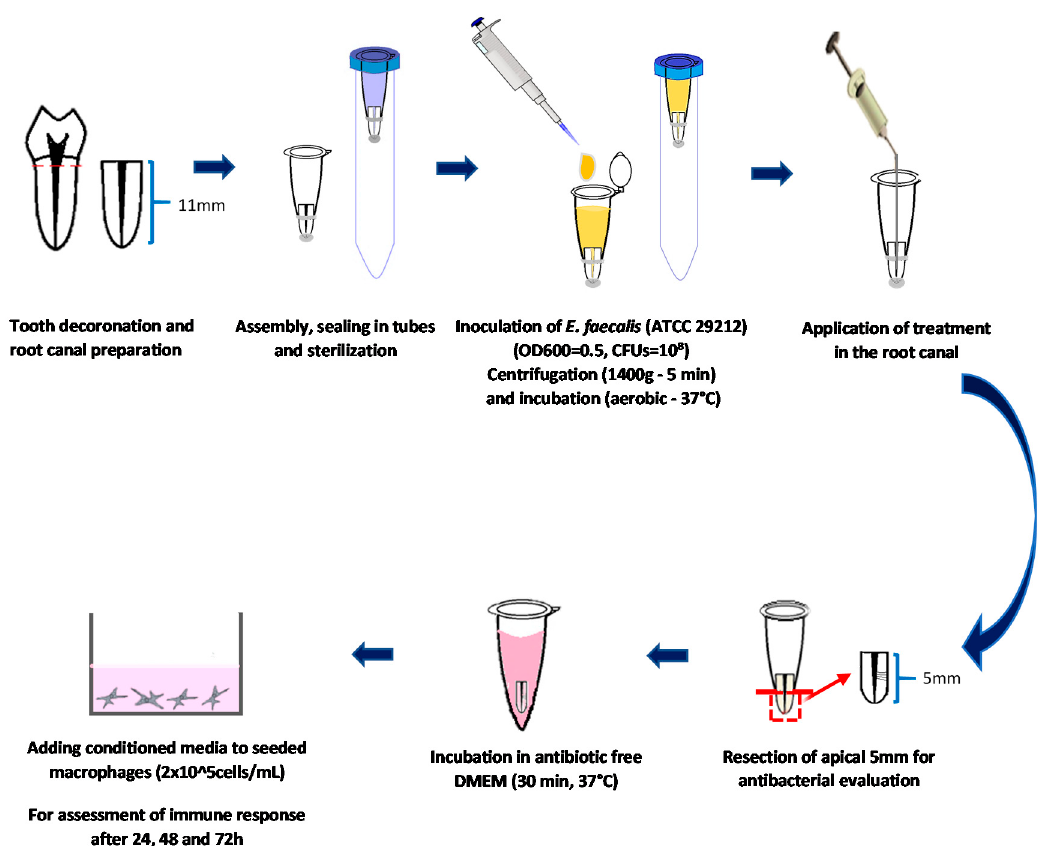
Figure 1. Schematic representation of the study methodology.